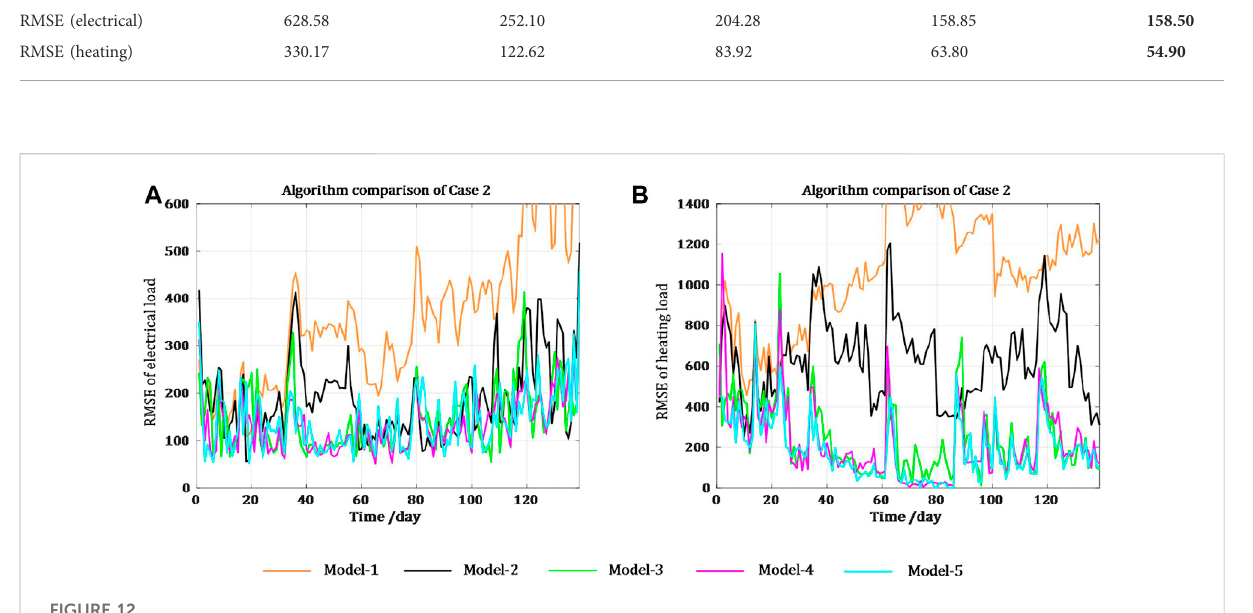
FIGURE 12 Comparison of the forecasting results in Case